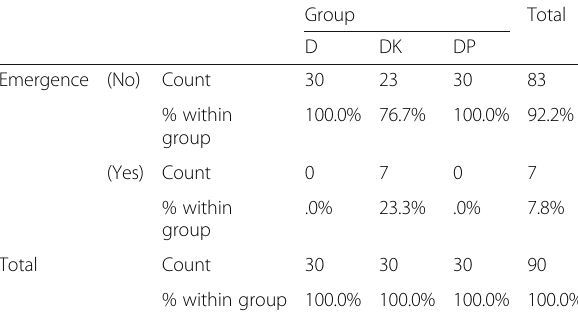
Table 2 Hemodynamic parameters (heart rate, mean blood pressure) Groups